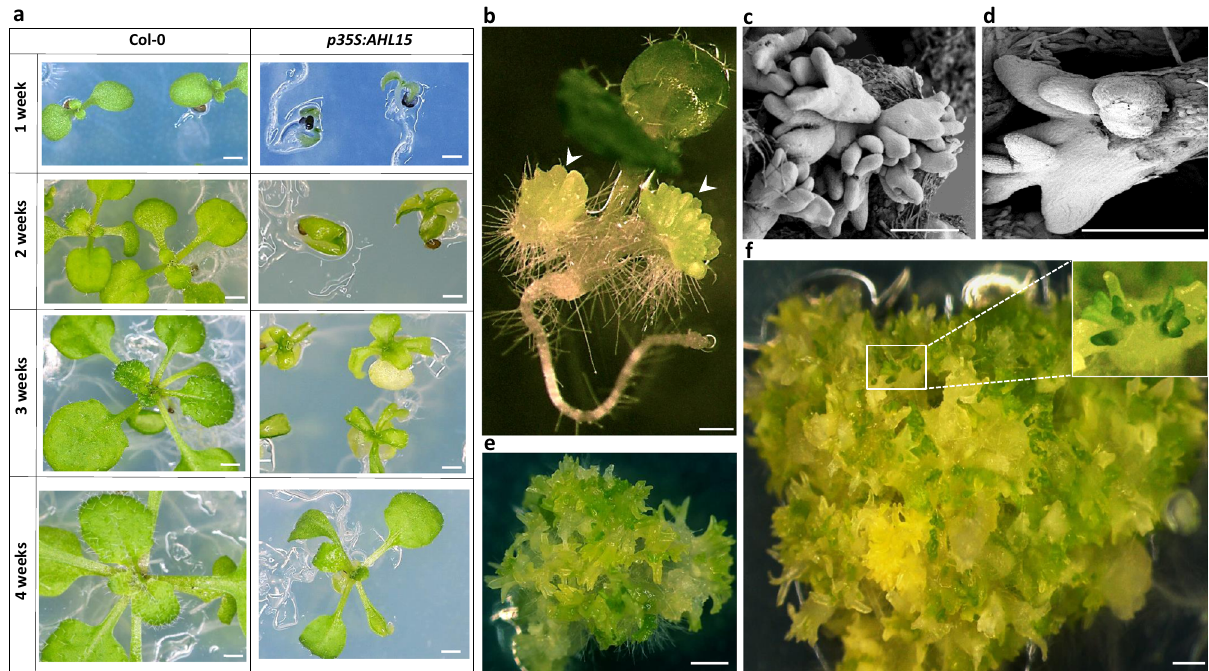
Fig. 1 Overexpression of AHL 15 delays Arabidopsis seedling development and induces SE. a The morphology of 1-week-old, 2-week-old, 3-week-old, and 4-week-old wild-type and p35S:AHL15 seedlings and plants grown in long day conditions (16 h photoperiod). b Two-week-old p35S:AHL15 Arabidopsis seedling with somatic embryos on the cotyledons (arrowheads). c , d Scanning electron micrographs showing torpedo stage somatic embryos on p35S: AHL15 cotyledons ( c ) or the secondary somatic embryos formed on a p35S:AHL15 primary somatic embryo ( d ). e The morphology of a 3-week-old AHL15 overexpression-induced embryonic mass following secondary SE. f The morphology of a 2-month-old embryonic mass formed from a p35S:AHL15 seedling. Size bars indicate 0.5 cm ( a ) and 1 mm ( b – f ). a – f Similar results were obtained from four independent indicate that wild-type AHL15, when suf fi ciently expressed, is